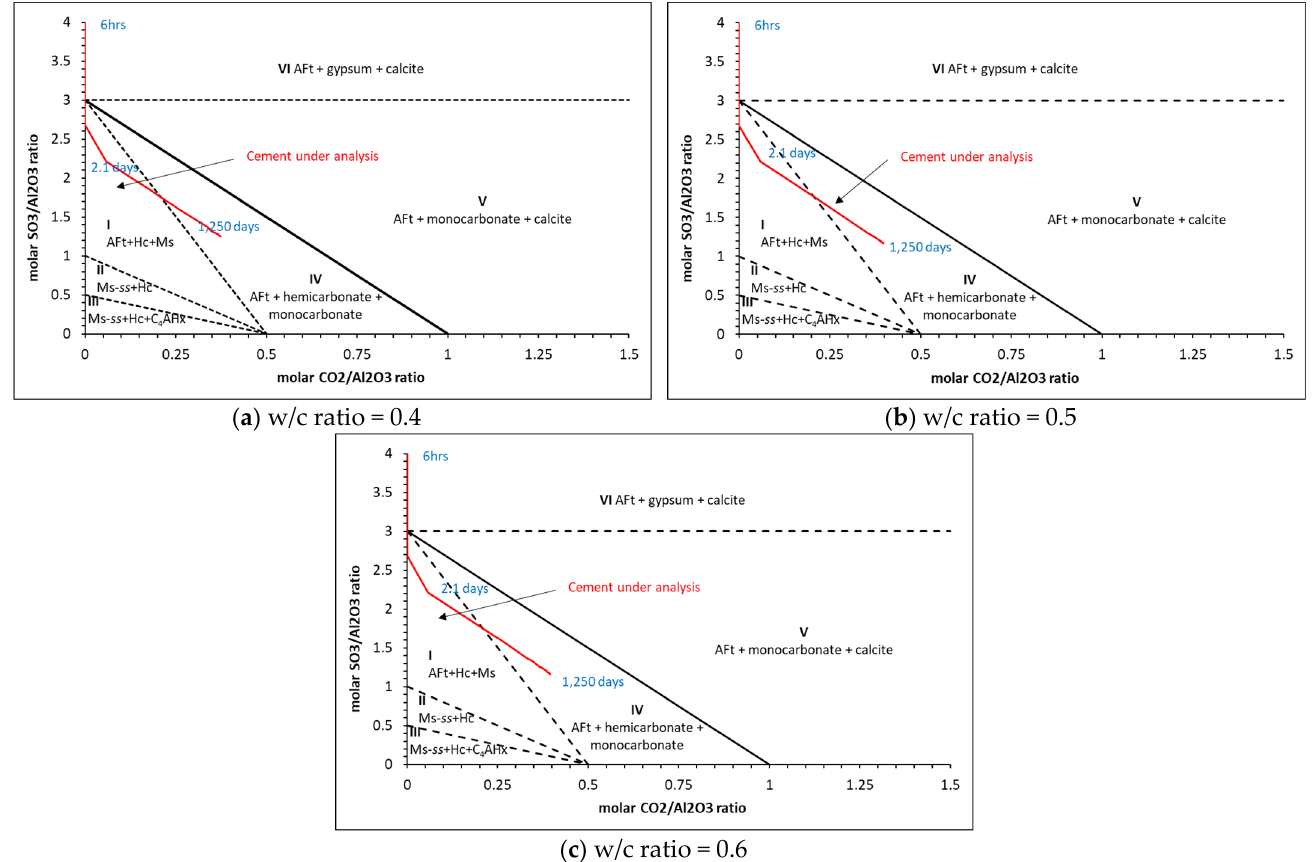
Figure 10. Calculated phase assemblages of a hydrated mixture for varying carbonate (CO 2 /Al 2 O 4 ) and sulfate (SO 3 /Al 2 O 4 ) ratios after Matschei et al. [8], showing the cement under analysis here (in red).